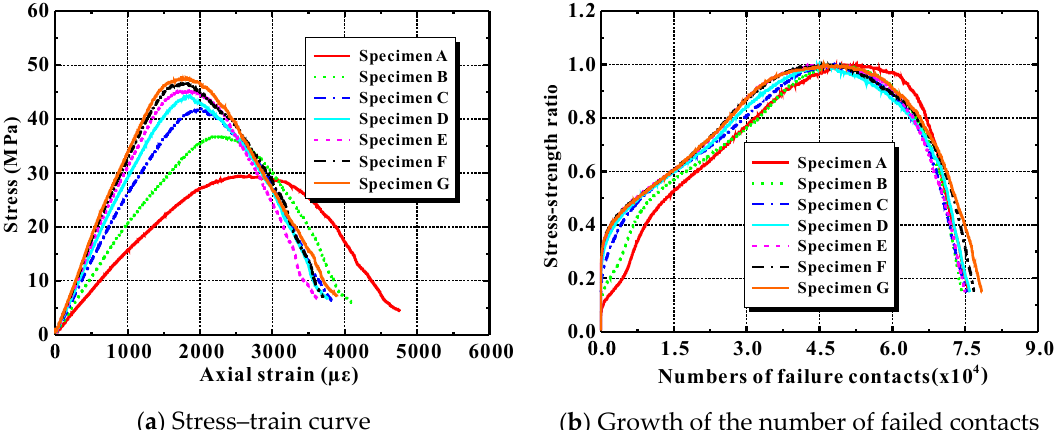
Figure 8. Microscale cracking in ordinary concrete at stress levels of 30% to 80% of the ultimate load by discrete element method (DEM). Figure 9a and Table 6 show the numerical compressive stress – strain relationships and the mechanical properties of the seven samples. It is easy to see from Figure 9a that the ITZs played an essential role in determining the compressive mechanical responses of ordinary concrete. When the